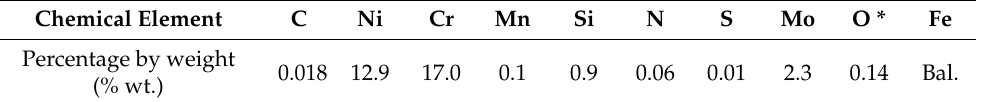
Table 1. Chemical composition of AISI 316L austenitic stainless steel powder [35]. Chemical